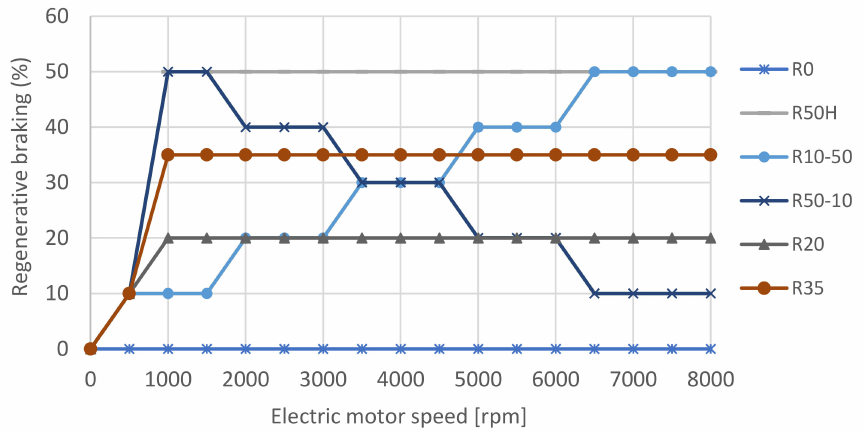
Figure 1. Base regenerative braking curves implemented into the electronic control unit (ECU).